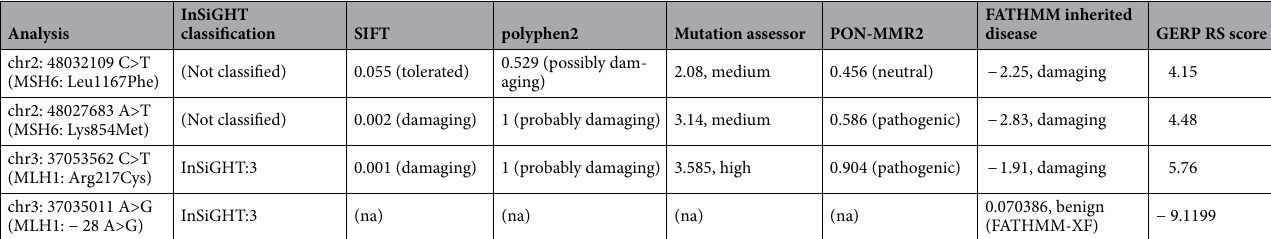
Table 2. In silico bioinformatics analyses of the identified variants. FATHMM-XF: non-coding score included.